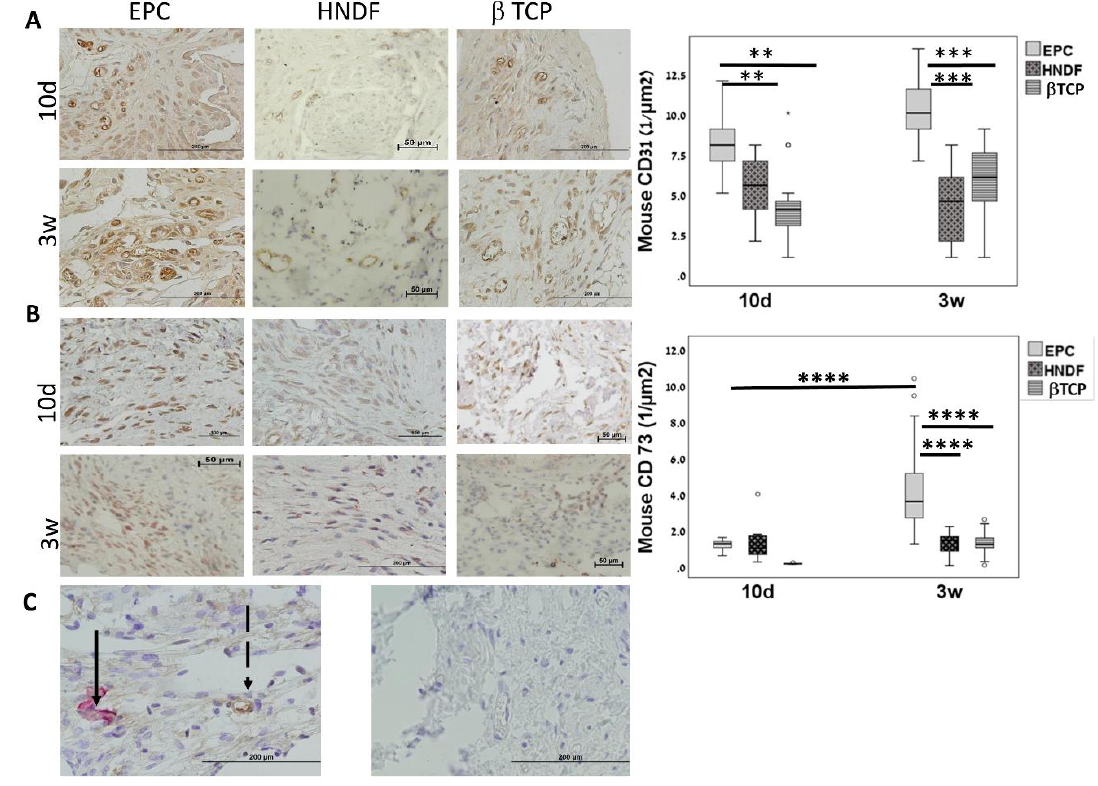
Figure 3. EPC recruit resident mesenchymal stem cells (MSCs) and ECs in vivo. ( A ) Recruitment of mouse CD31+ cells was assessed using anti mouse CD31 antibody. Immunostaining levels were quantified with Image Pro software (Rockville, MD, USA) ** p < 0.01. º means outlier, ★ means extreme outlier. Scale = 200μm . ( B ) Recruitment of mouse CD73+ cells was assessed using anti mouse CD73 antibody. Immunostaining levels were quantified with Image Pro software (Rockville, MD, USA). **** p < 0.0001. º means outlier. Scale = 100μm . ( C ) Double immunostaining with HNA antibody and anti-mouse CD73 of a representative slide from the EPC group showed proximity between the EPC (brown staining, dashed arrow) and mouse MSC (red staining, arrow). For negative control, double staining without primary antibodies was performed. Scale = 200μm.